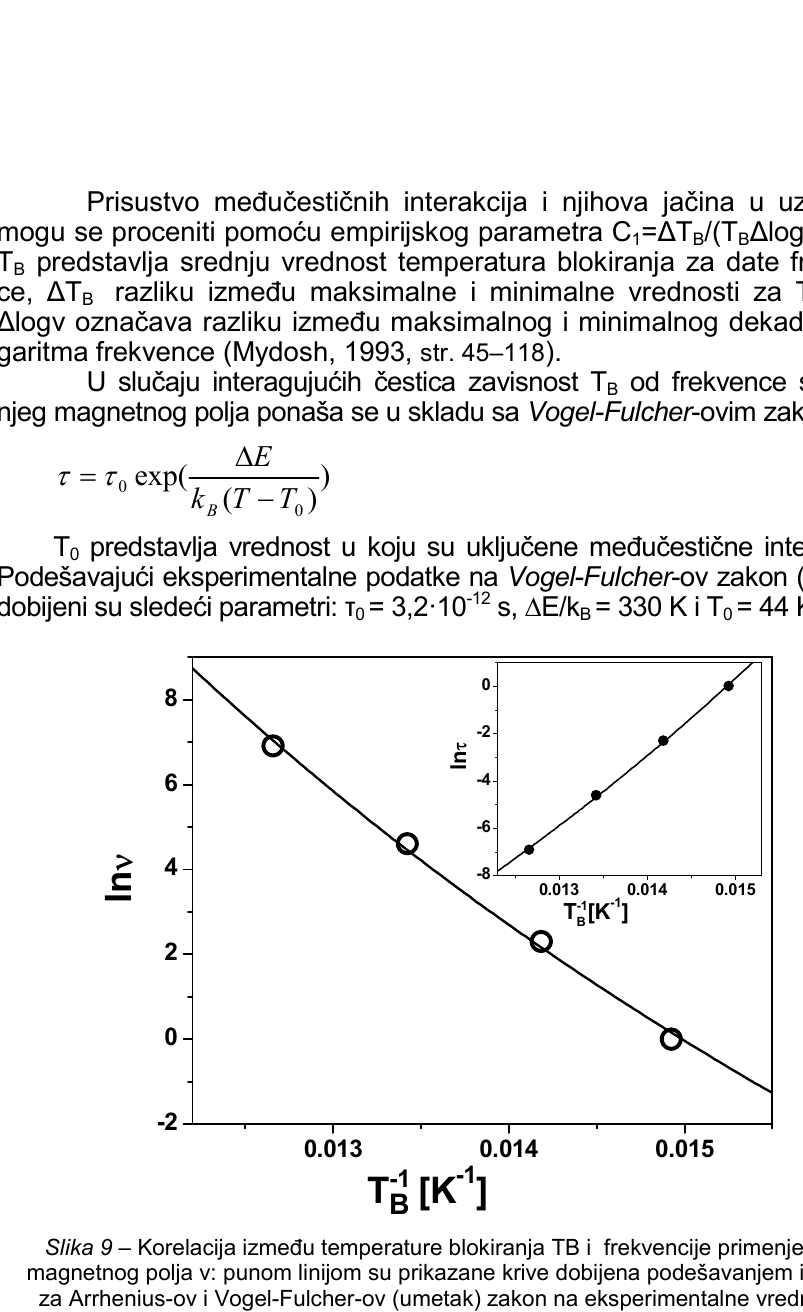
za Arrhenius-ov i Vogel-Fulcher-ov (umetak) zakon na eksperimentalne vrednosti Figure 9 – Change of blocking temperature TB with AC field frequency ν fitted to the Arrhenius function. Inset: fit to the Vogel-Fulcher function Vrednost parametra ∆ E/k može se iskoristiti za odre đ ivanje B